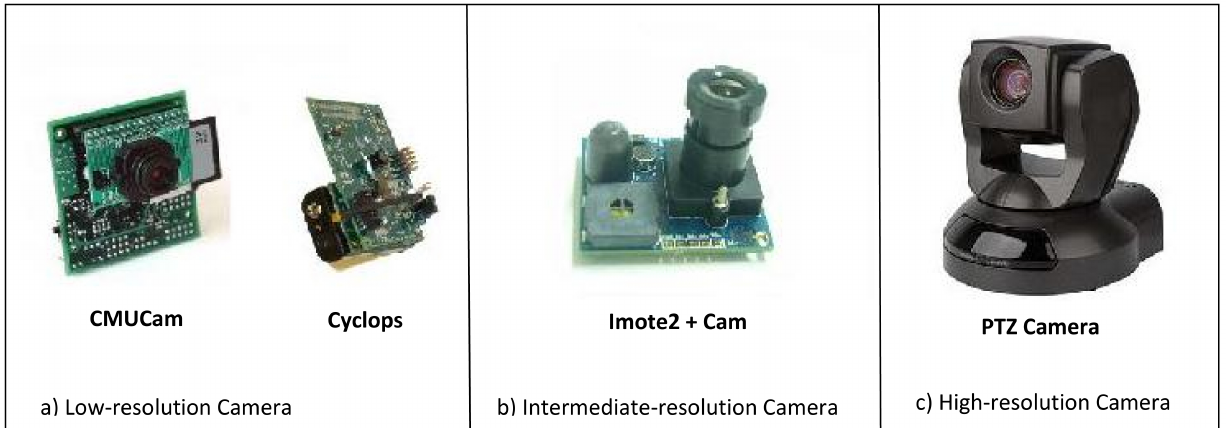
Figure 6. Examples of Camera Mote